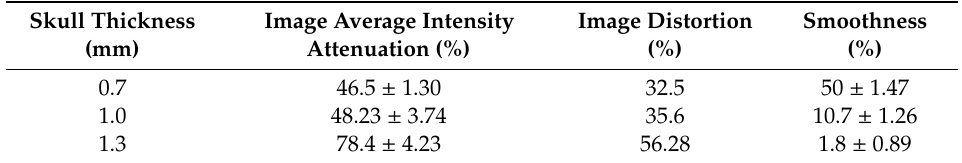
Figure 5. Optical energy measured with di ff erent thicknesses of ( a ) sheep brain tissue and ( b ) the brain tissue-mimicking phantom (gelatin + fiber) with a skull bone to block the illumination path with a thickness of ( i ) 0.7, ( ii ) 1.0, or ( iii ) 1.3 mm. Optical fiber bundle was placed on top of the brain tissue or the brain-like tissue-mimicking phantom. T b : brain tissue thickness; T m : tissue-mimicking phantom thickness. Table 1. Summary of the quantitative evaluation of the US imaging through the skull in gelatin with a fiber mixture with di ff erent thicknesses. Please see the definition of the quantitative parameters in Section